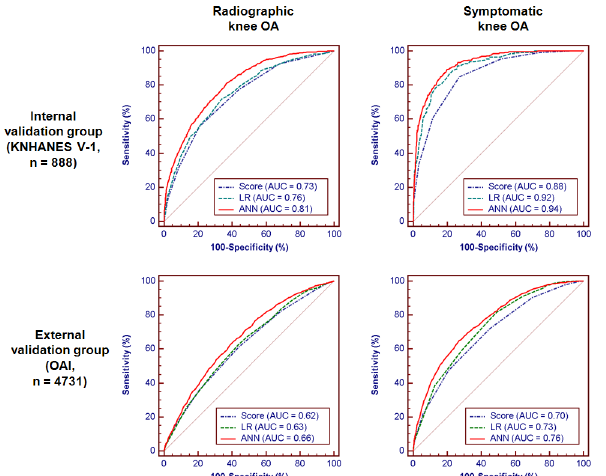
Fig 3. ROC curves for radiographic and symptomatic knee osteoarthritis in internal and external validation groups. ANN, artificial neural network; AUC, area under the receiver operating characteristic curve; KNHANES, Korea National Health and Nutrition Examination Survey; LR, logistic regression; OA, osteoarthritis; OAI, Osteoarthritis Initiative.